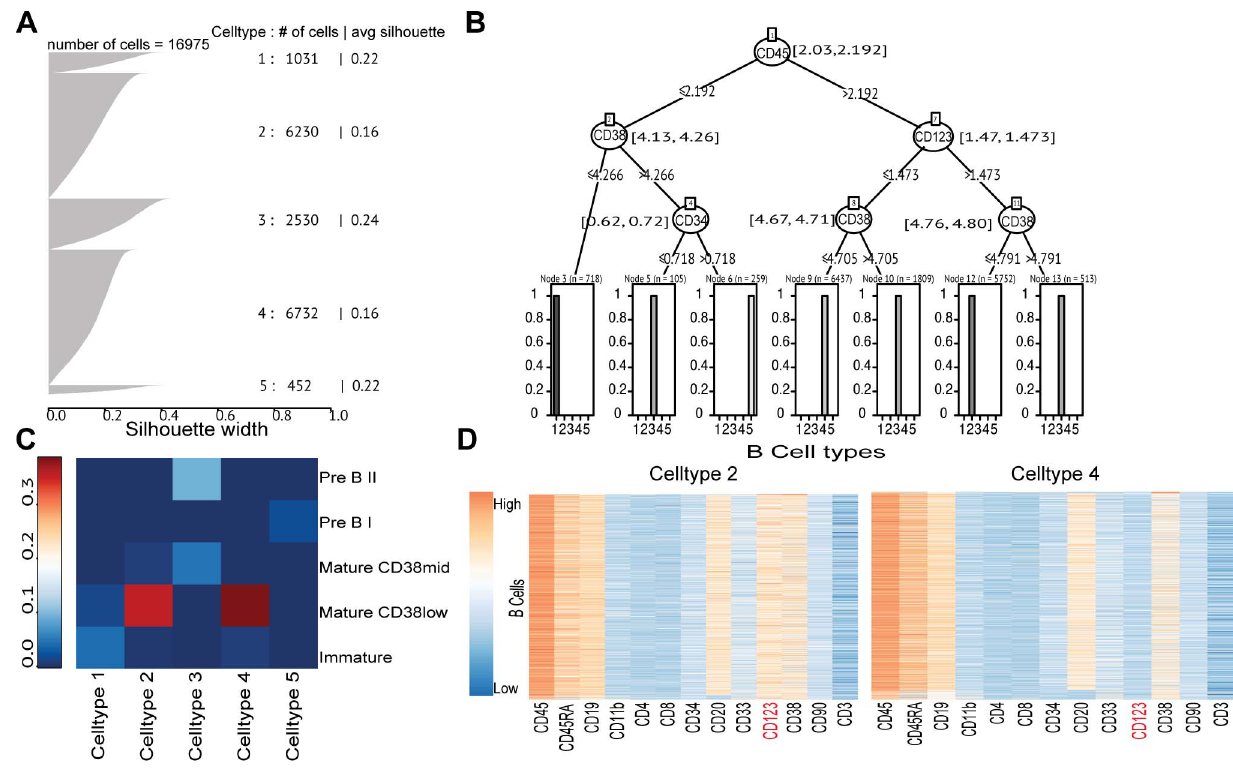
Figure 4. CCAST applied to single cell analysis of B-cells. A Silhouette plot showing evidence of 5 B-cell types. B CCAST gating strategy for B- cell types based on CD45, CD34, CD38, and CD123 markers using 3 levels of gating. The estimated ranges for the split point variables are provided at each node. Note Celltype 3 is distributed across three gated populations. C Cross classification heatmap of manually gated and CCAST predicted B- cell types indicates strong evidence that the most abundant Mature CD38low B-cells comprise a mixture of other subtypes (Celltype 2 and 4). D Heatmaps show evidence of the two derived distinct mature B-cell states corresponding to Celltypes 2 and 4 based mainly on CD123 (label highlighted in